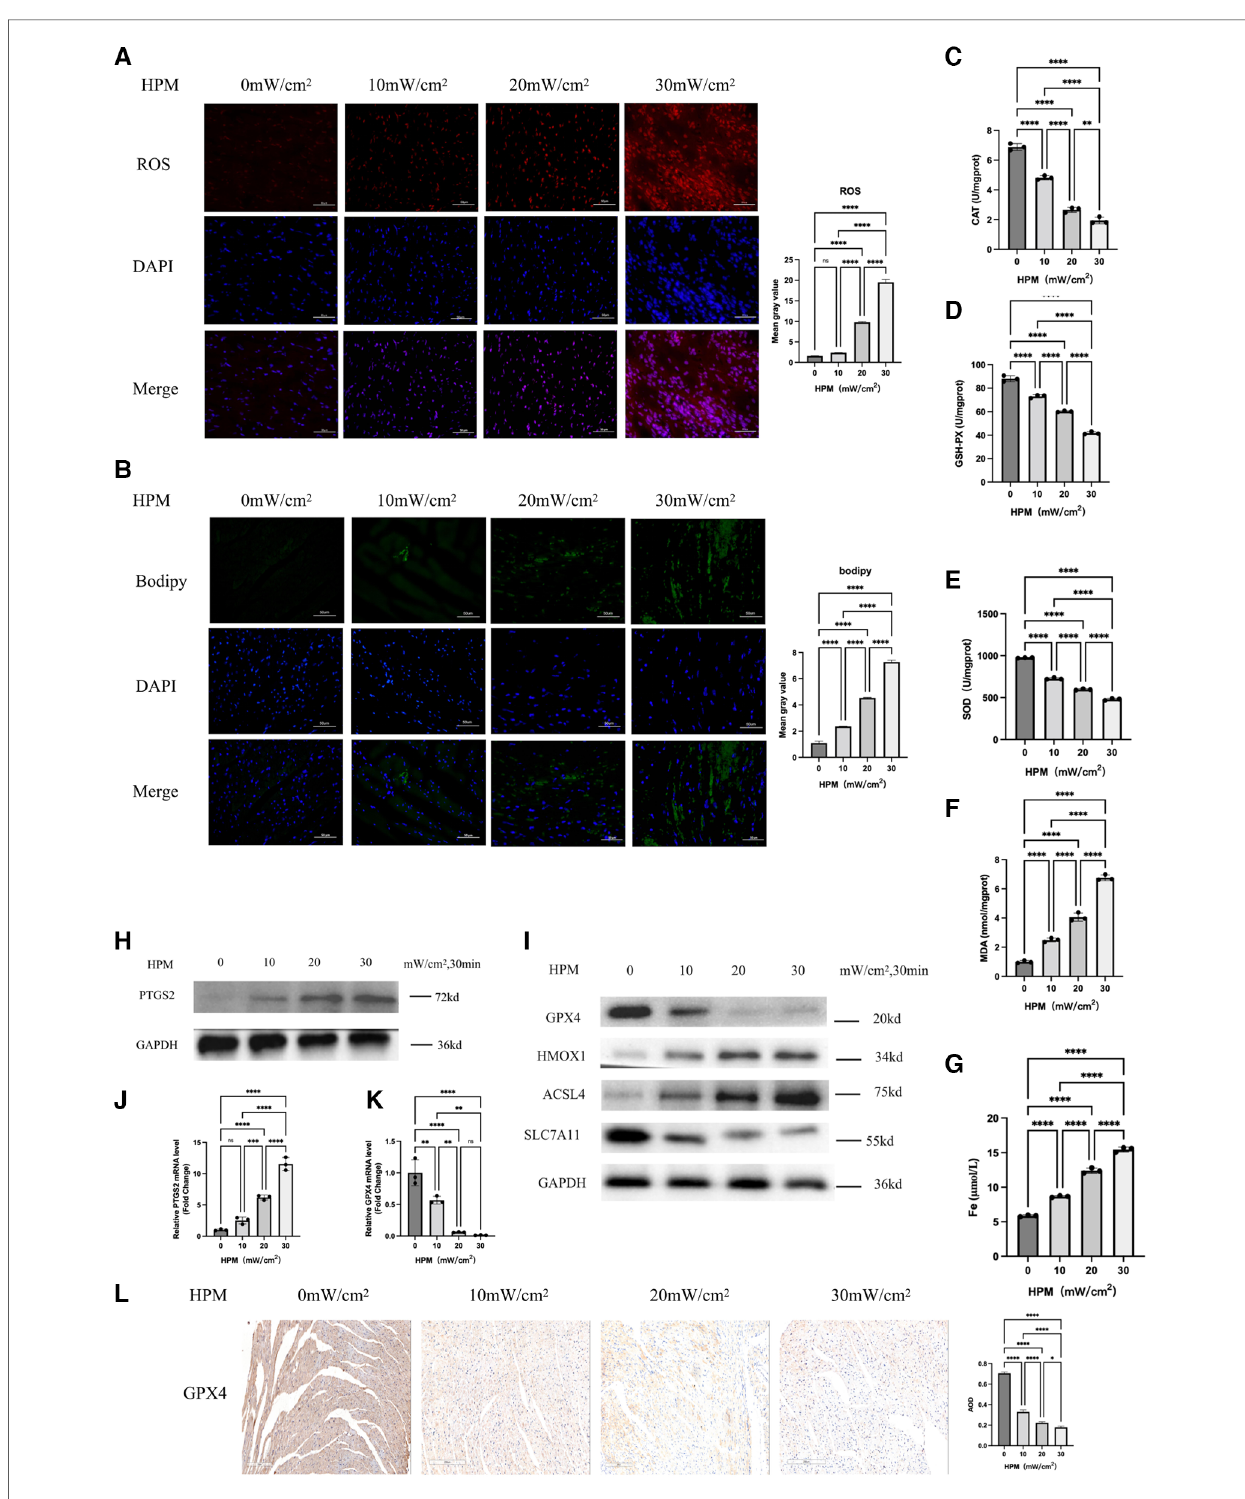
FIGURE 2 Ferroptosis occurs in myocardial tissue of HPM mice ( n =6). ( A,B ) Immuno fl uorescence technique staining of ROS, bodipy and DAPI in myocardial section were conducted and corresponding fl uorescence statistics. Scale bar: 50 μ m. ( C – F ) Elisa kit detect MAD, CAT, SOD and GSH of myocardial redox status in mice. ( G ) Serum Fe concentration in mice. ****, P <0.0001, one-way ANOVA, post hoc comparisons, Tukey ’ s test. ( H,I ) Protein levels of PTGS2, GPX4, HMOX1, ACSL4, SLC7A11 from the myocardial tissue in HPM-mice were analyzed with Western blot. ( J,K ) qRT-PCR analysis of PTGS2, GPX4 mRNA level was done in the myocardial tissue. **, P<0.01, one-way ANOVA. ( L ) Immunohistochemistry (IHC) staining of GPX4 in myocardial tissue sections were conducted and corresponding statistics. Scale bar: 200 μ